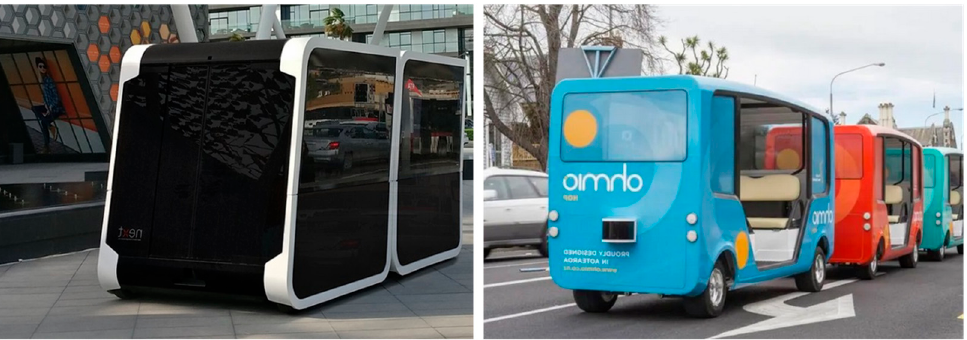
Figure 1. Electric modular vehicles (source: https://www.next-future-mobility.com, accessed on 5 June 2021 and https://ohmio.com, accessed on 5 June 2021).